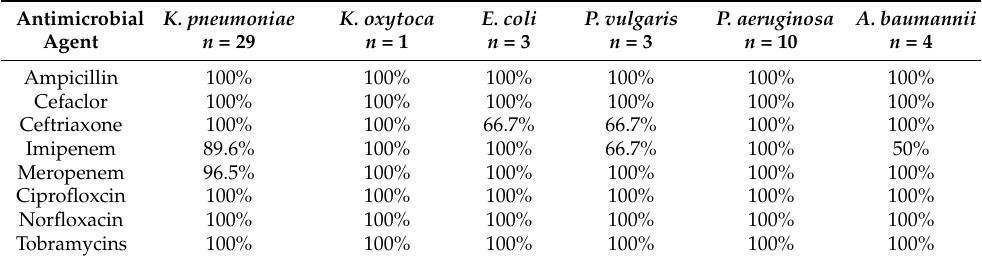
Table 1. Antibiotic resistance profile of isolates from chest ICU.